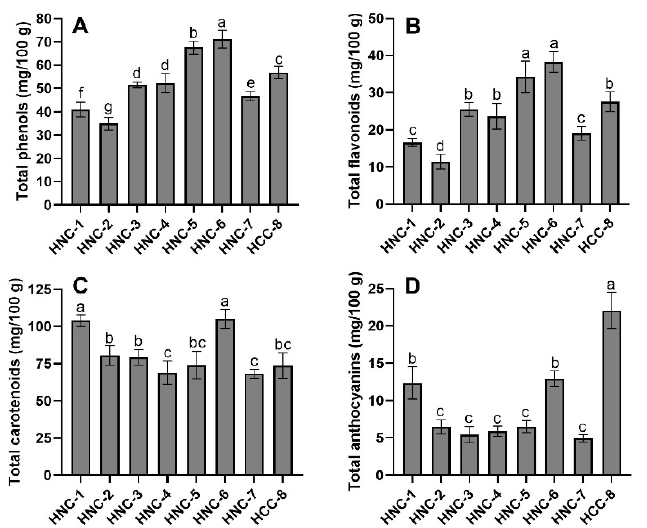
Figure 5. Content of total phenols ( A ), total flavonoids ( B ), total carotenoids, ( C ) and total anthocyanins ( D ) in fruits of eight genotypes of habanero pepper grown in the southeast of Coahuila. Values are the average of four replications. Means ( n = 4). Bars represent the standard deviation of the mean. Different letters in each bar mean that the genotypes were statistically different (Tukey, p ≤ 0.05).